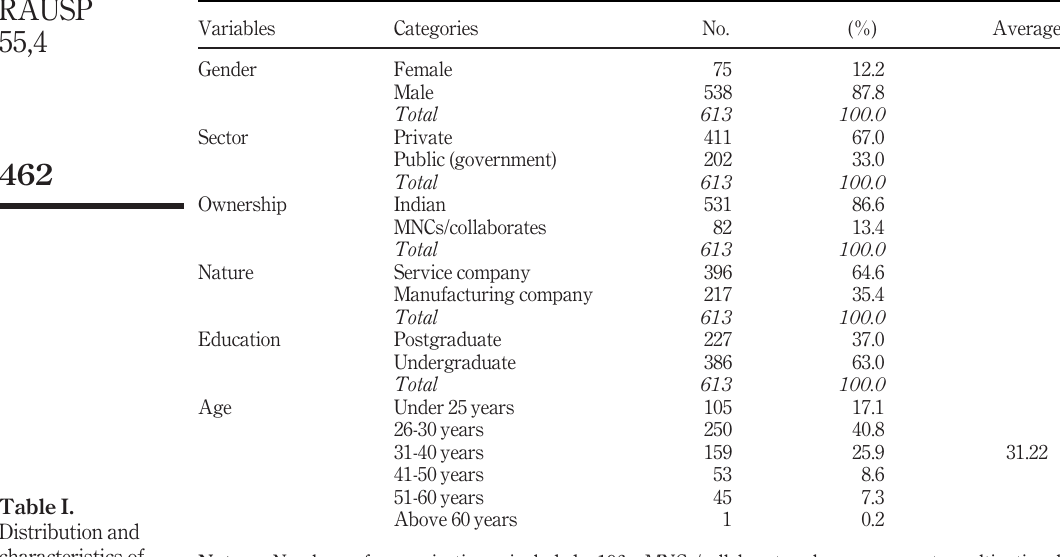
characteristics